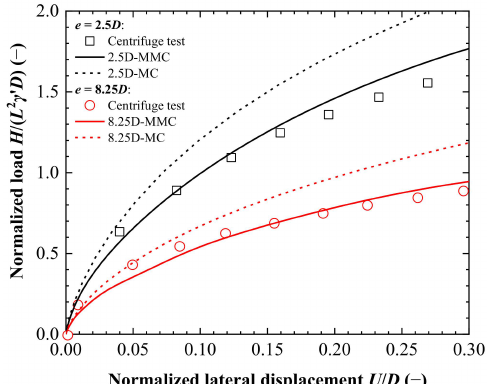
Figure 6. Comparison of finite element results with centrifuge test results